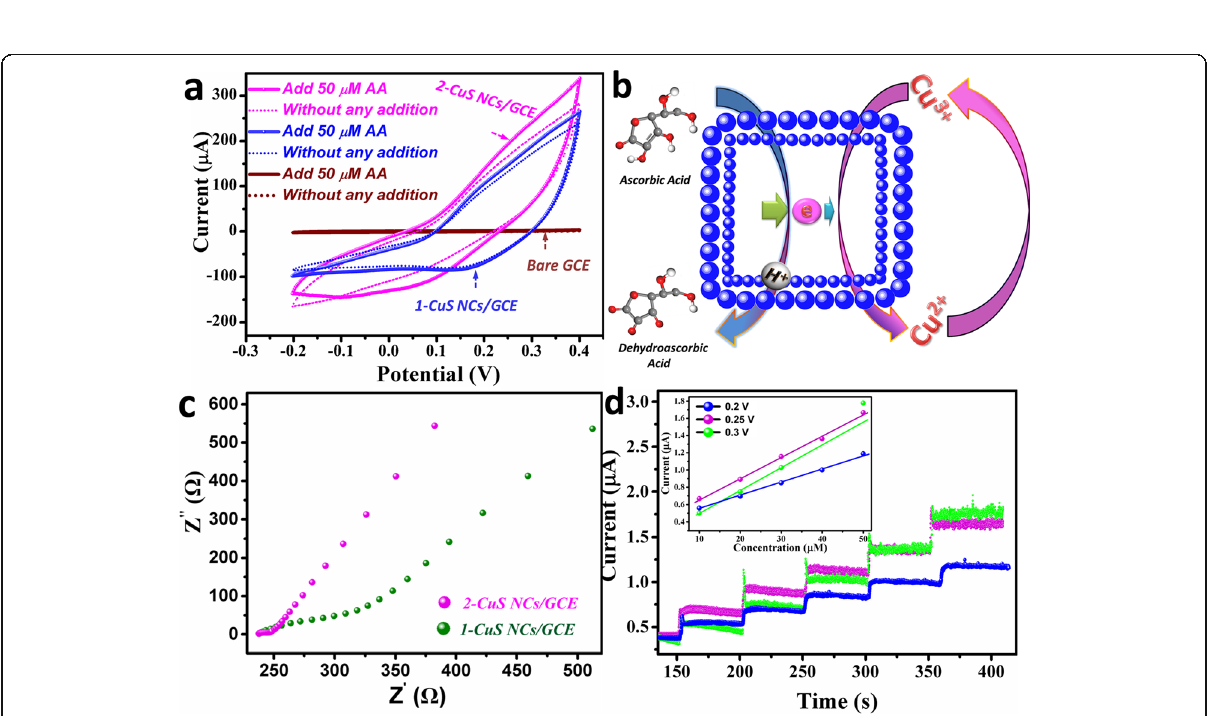
Fig. 4 a CVs of 2-CuS NCs/GCE, 1-CuS NCs, and bare GCE at 50 mV s − 1 . b The catalytic mechanism of AA oxidation on 2-CuS NCs/GCE. c Nyquist plot of 2-CuS NCs/GCE and 1-CuS NCs/GCE. d i - t response towards 25- μ M AA